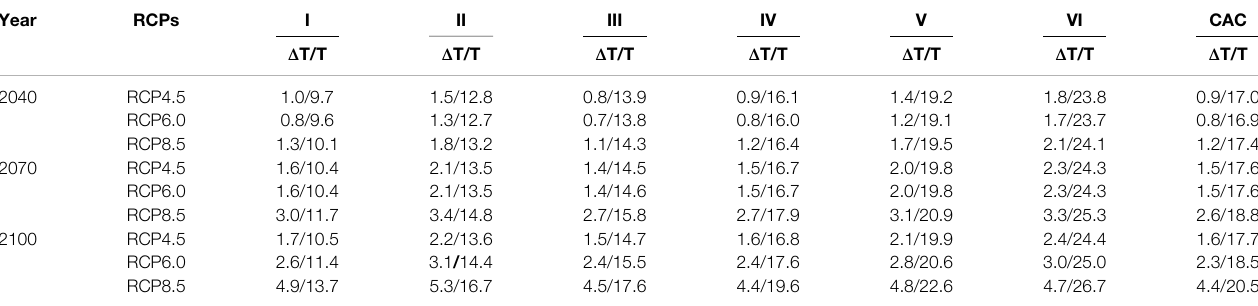
TABLE 2 | The changes of annual average Tmean relative to the base period 1996 – 2018 and the projected annual average Tmean for 2040, 2070, and 2100 with different RCPs over CAC (Unit: ° C).